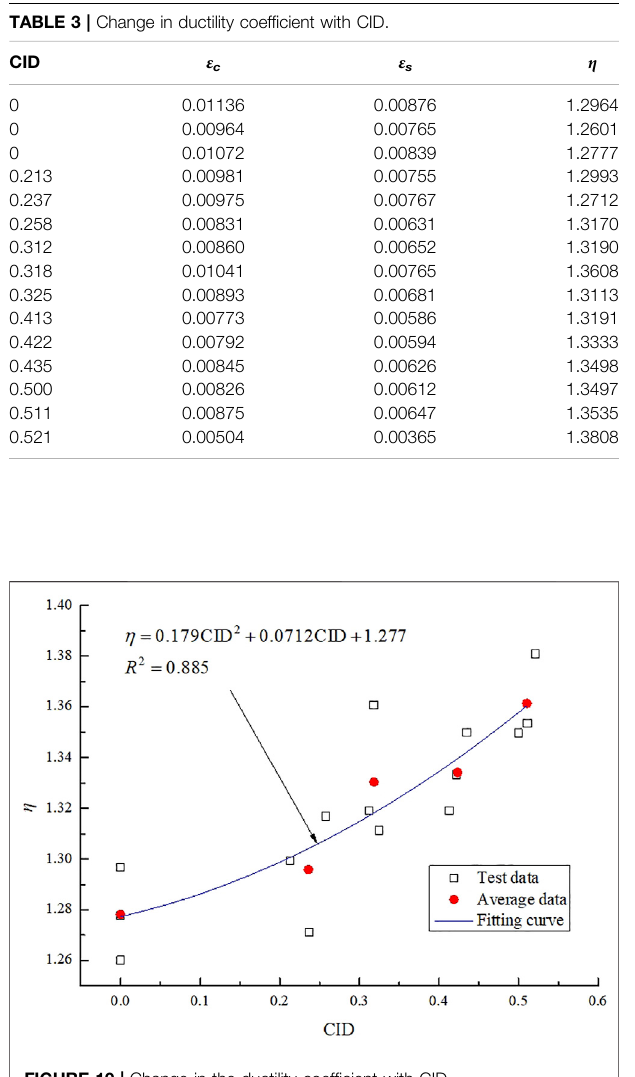
FIGURE 10 | Change in the ductility coef fi cient with